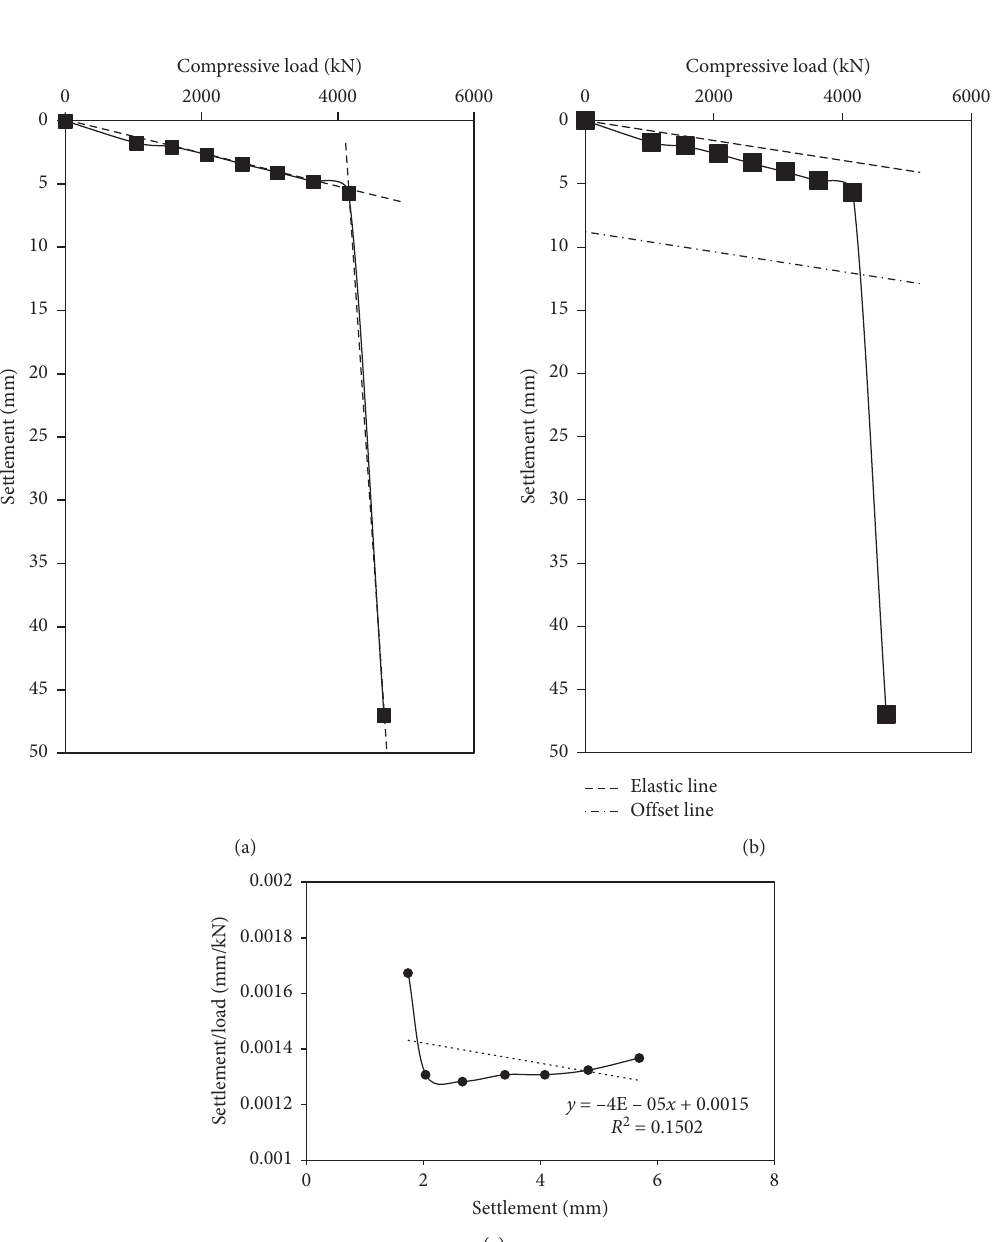
Figure 19: s-lgQ curve of